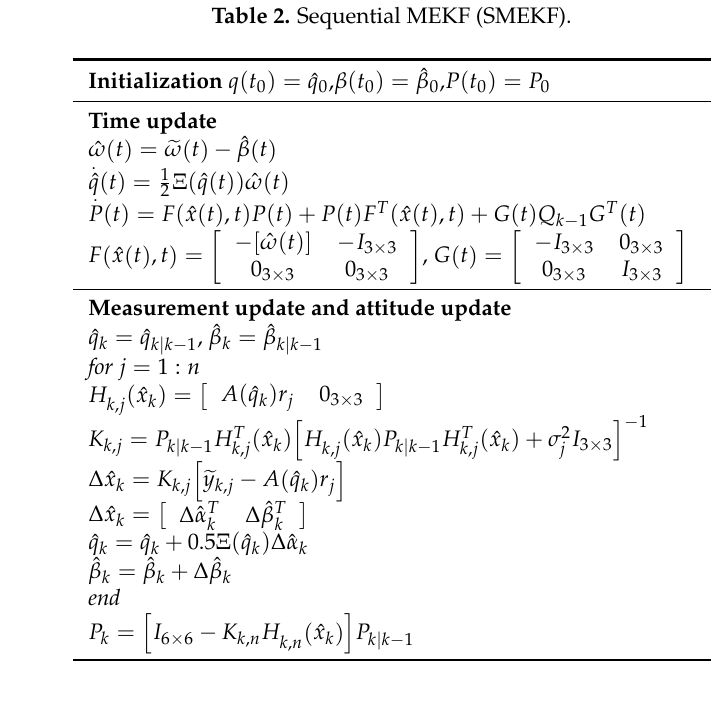
Table 2. Sequential MEKF